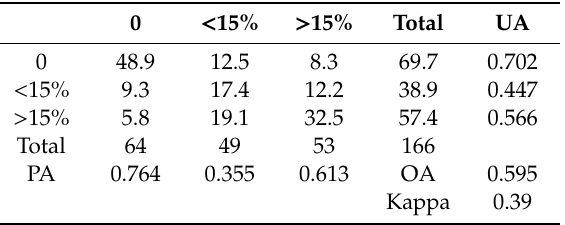
Table 7. Confusion matrix for three class classifications with the SVM algorithm using S2 10 m resolution images; 15% < the third class <